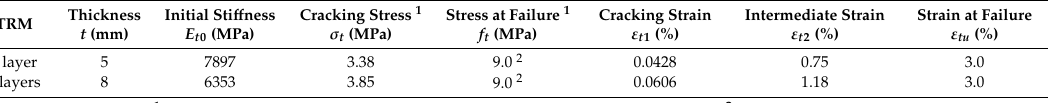
Table 7. Mechanical properties of TRM coupons.